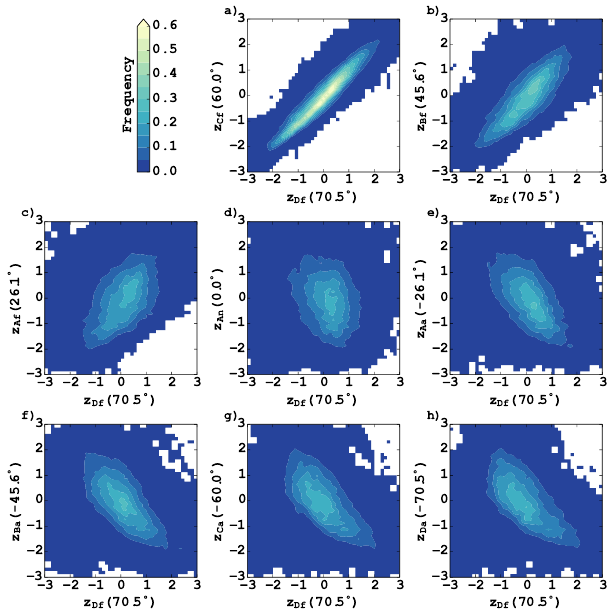
Figure 3. (a–h) Joint probability distributions ( P(z i ,z j ) ) of NIR standard scores (see Eq. 4) between MISR’s Df ( θ m = 70 . 5 ◦ , x axis) and the remaining eight cameras. All θ 0 and φ angles are